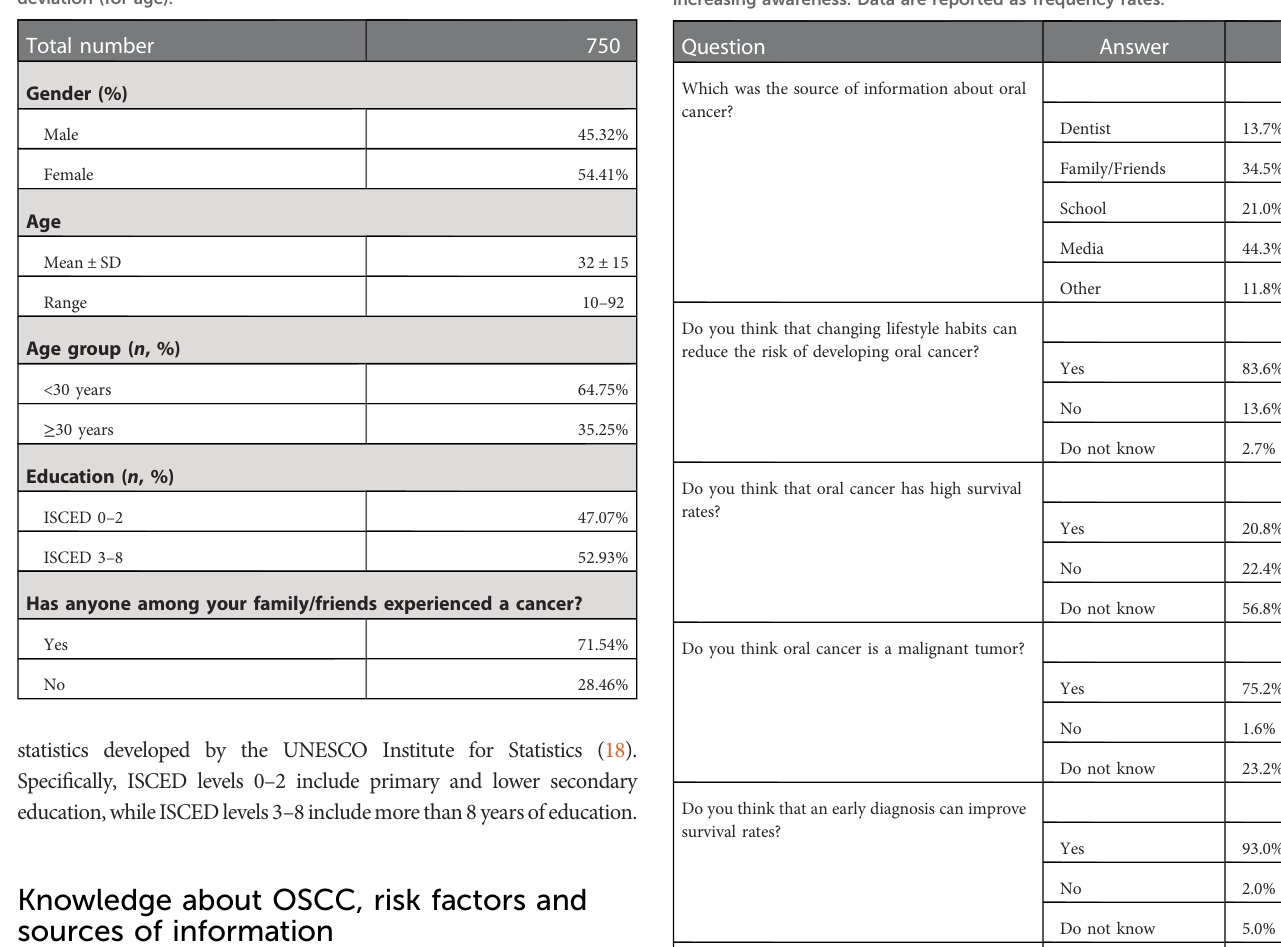
TABLE 2 Knowledge about OSCC, possible risk factors, sources of information, possible interventions and their timing to contribute increasing awareness. Data are reported as frequency